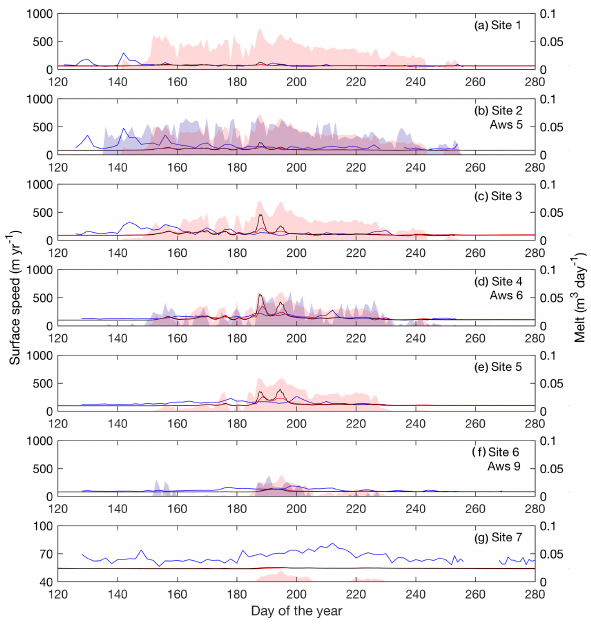
Figure 6. Modelled ice velocities plotted against GPS measure- ments for the 2009 melt season. Daily average horizontal velocity from GPS measurements are plotted in blue. Modelled velocities using the Schoof sliding law and Budd sliding law are plotted in black and red, respectively. Daily ablation from weather stations are shown in shaded blue, while RACMO2.3 surface runoff is shown in shaded red. Locations of GPS and weather station sites are shown Fig. 1. Weather station ablation rates are plotted at the nearest GPS site.